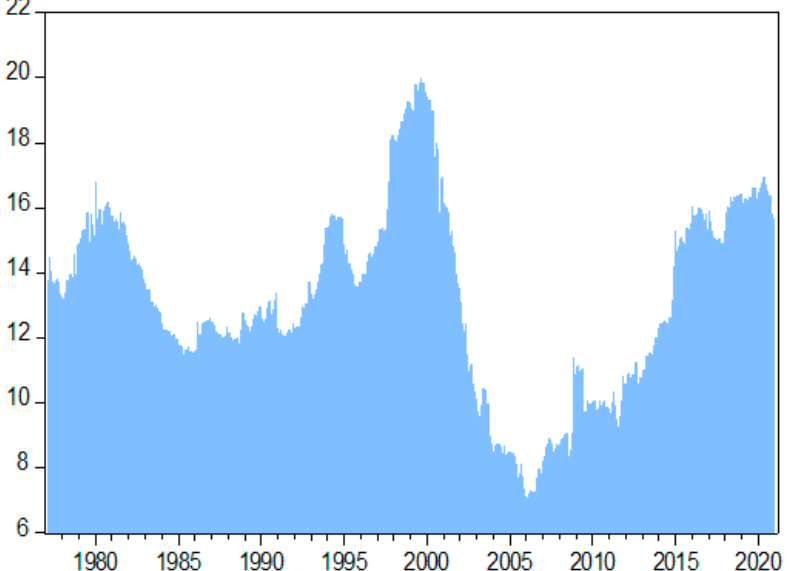
Figure 2. Overall inflation spillovers with the Diebold and Yilmaz (2012) methodology. Figure 3 represents inflation spillovers in each of the G7 countries from the other remaining countries. For example, the subtitle “Canda.From” represents the graph of in- flation spillover in Canada from the other G7 countries. Figure 3 represents that inflation spillovers from the other G7 countries to Canada, France, Germany, Italy, and the United Kingdom have been rising after 2005. For Japan and the United States, this spillover index remains pretty much constant after 2005, indicating that these two countries are creating inflation spillover to the other G7 countries.